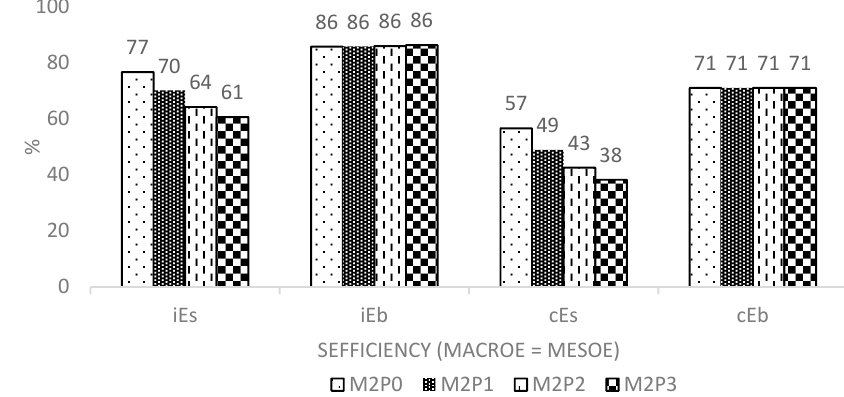
Figure 8. Sustainable efficiency (Sefficiency) for M2P.